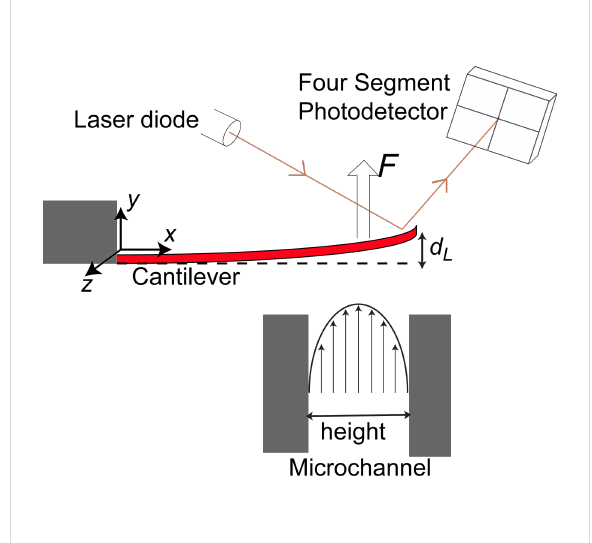
Figure 1: Schematic side view of the microchannel with Poiseuille profile of the fluid and a cantilever that bends due to forces exerted by the